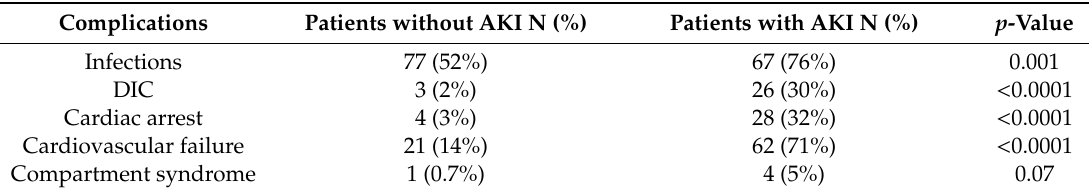
Figure 2. Correlation between the peak serum creatine kinase (CK) and the peak serum creatinine in the poisoned patients who developed rhabdomyolysis. Table 3. Complications in the intensive care unit poisoned patients who developed rhabdomyolysis with vs. without acute kidney injury